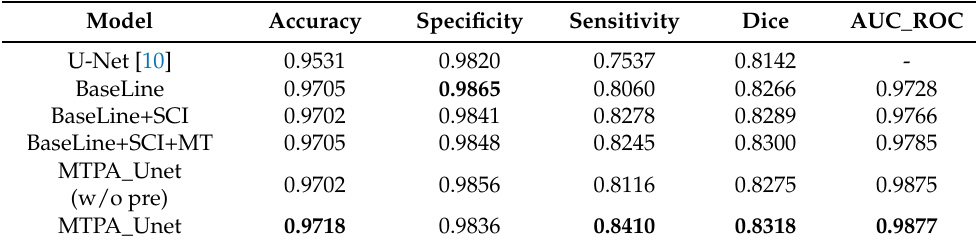
Table 1. Ablation experiments on the DRIVE dataset.